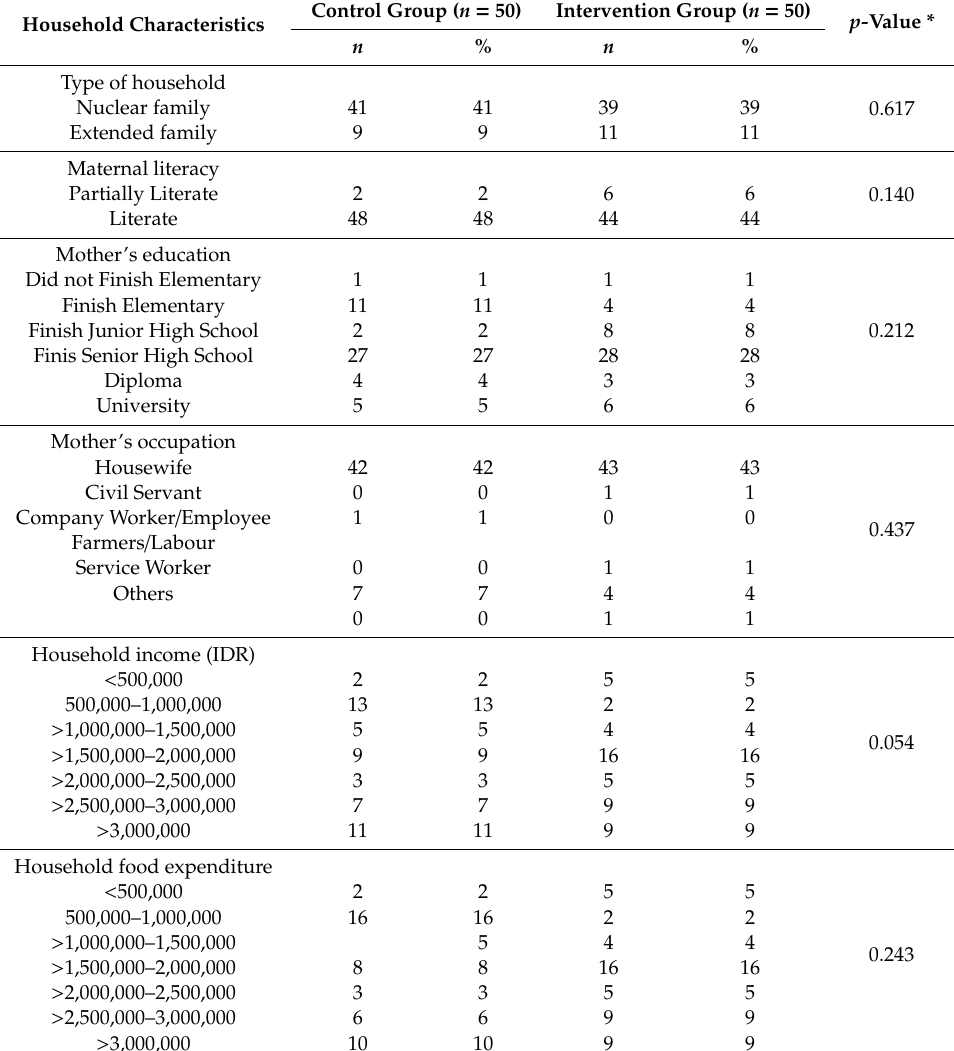
Table 2. Household